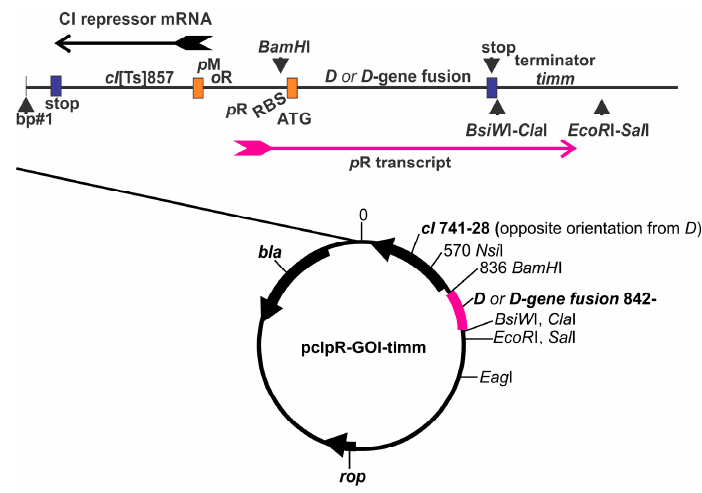
Figure 2. Map for the synthetic plasmid pcIpR-GOI-timm expression vector, used to clone any Gene of Interest (pink), e.g., the D- fusion gene shown, with ATG for GOI at base 842 of plasmid. In the versions of this plasmid used herein where the gene of interest (GOI) represents D or D- fusions, the wild type sequence for D was synthetically optimized in 55 of its 110 codons [26,27] to improve translation e ffi ciency. This version of D is termed D coe and the protein product is called gpDcoe (representing co don e nhanced). The sequence of D coe is provided in the supplement to reference [26], where D coe was fused to a linker and four regions of the porcine Circovirus 2 capsid gene, i.e., on plasmid pcIpR- D -CAP-timm. Base assignments after 842 depend on the size of the GOI insertion and so are not shown. All